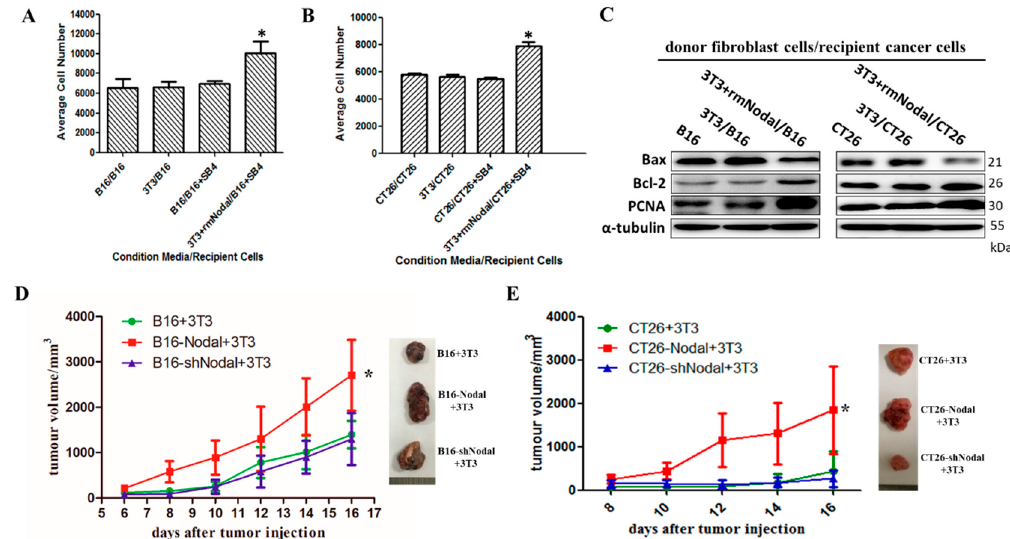
Figure 4. Fibroblasts activated by Nodal support tumor growth in melanoma and CRC. ( A ) B16 and ( B ) CT26 cells in the presence of SB431542 were grown in 3T3-conditioned media or 3T3-Nodal-treated-conditioned media without FBS for 48 h and the total number of cells was counted by Cell Counting Kit 8 (* p < 0.05). ( C ) The level of Bax, Bcl-2, and PCNA proteins from B16 or CT26 alone or co-cultured with 3T3 pretreated with Nodal protein were analyzed by western blotting. ( D ) Tumor growth curves of B16 + 3T3, B16-Nodal + 3T3, and B16-shNodal + 3T3 groups and the representative images of tumors are presented. ( E ) Tumor growth curves of CT26 + 3T3, CT26-Nodal + 3T3, and CT26-shNodal + 3T3 groups and the representative images of tumors are presented. * p <